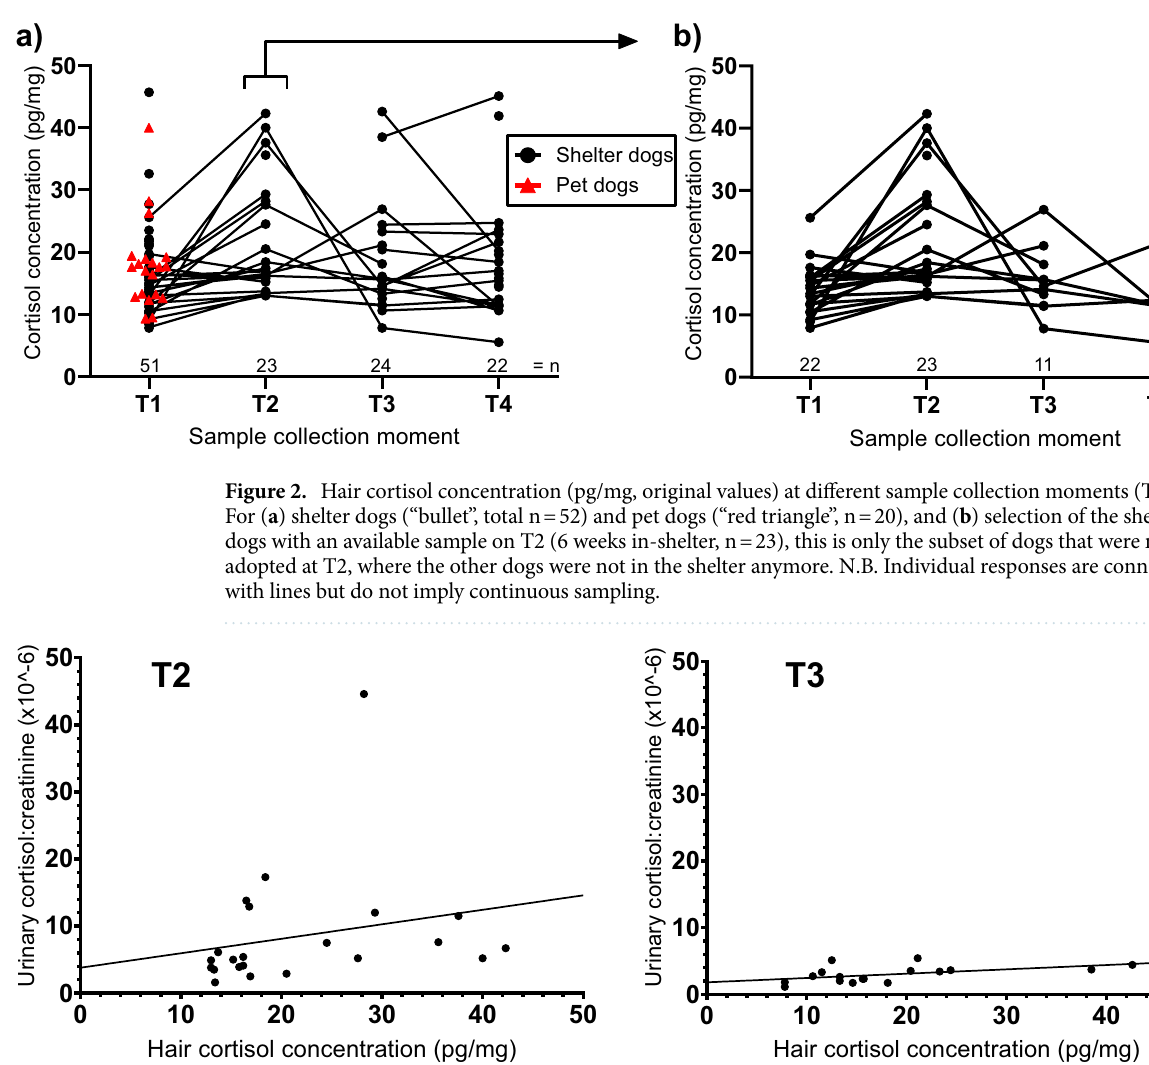
Figure 3. Correlation between hair cortisol concentration (pg/mg) and urinary cortisol:creatinine (× 10^-6) in shelter dogs. For sample collection moments T2 (n = 21) and T3 (n =